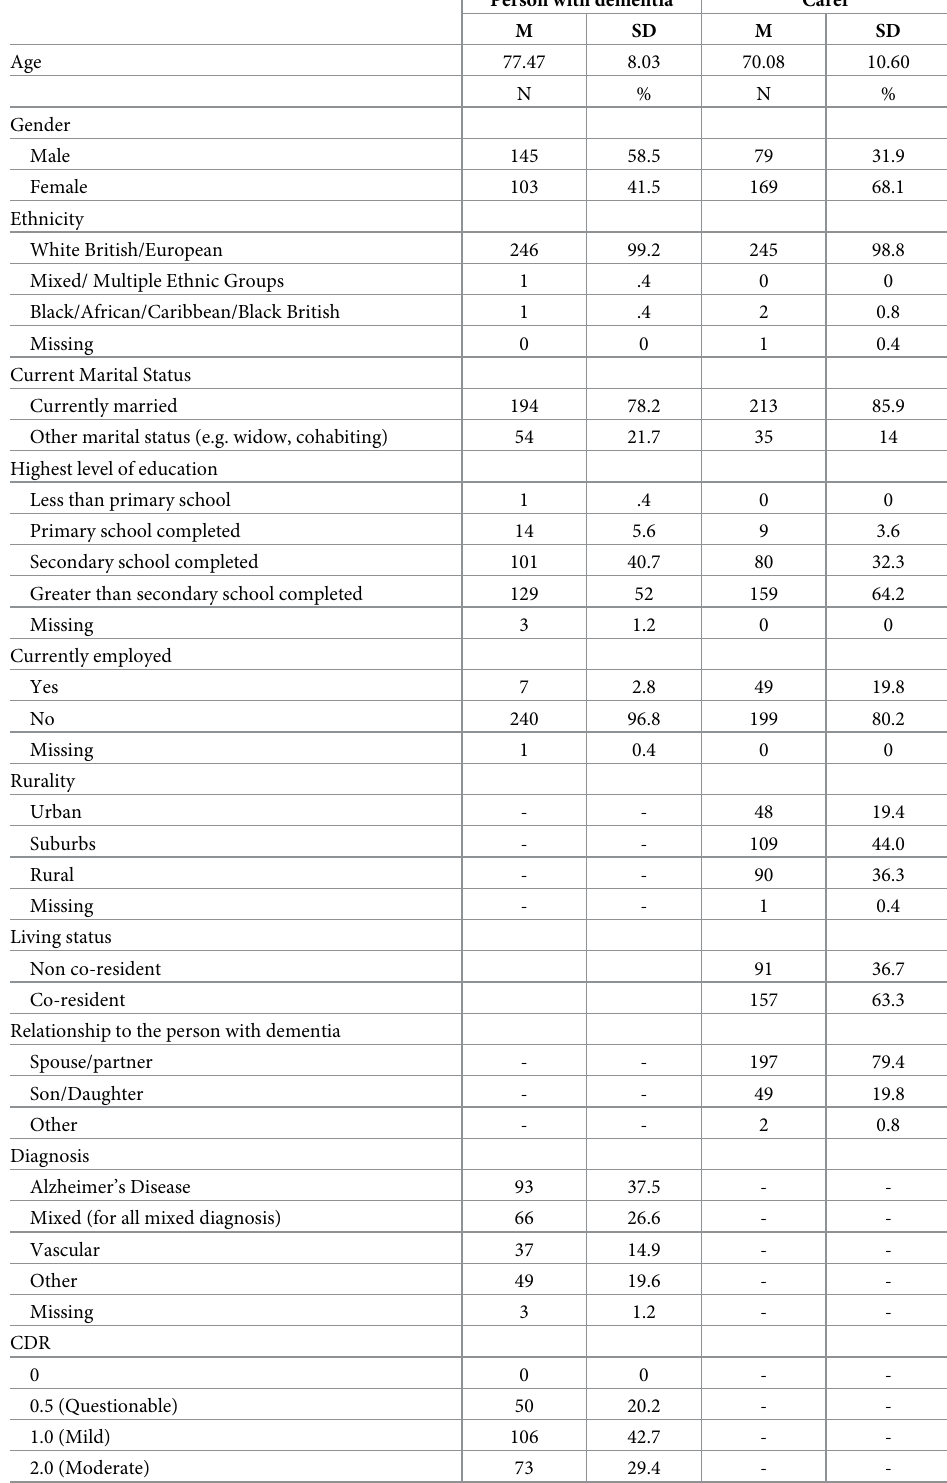
Table 1. Baseline participant characteristics (n =